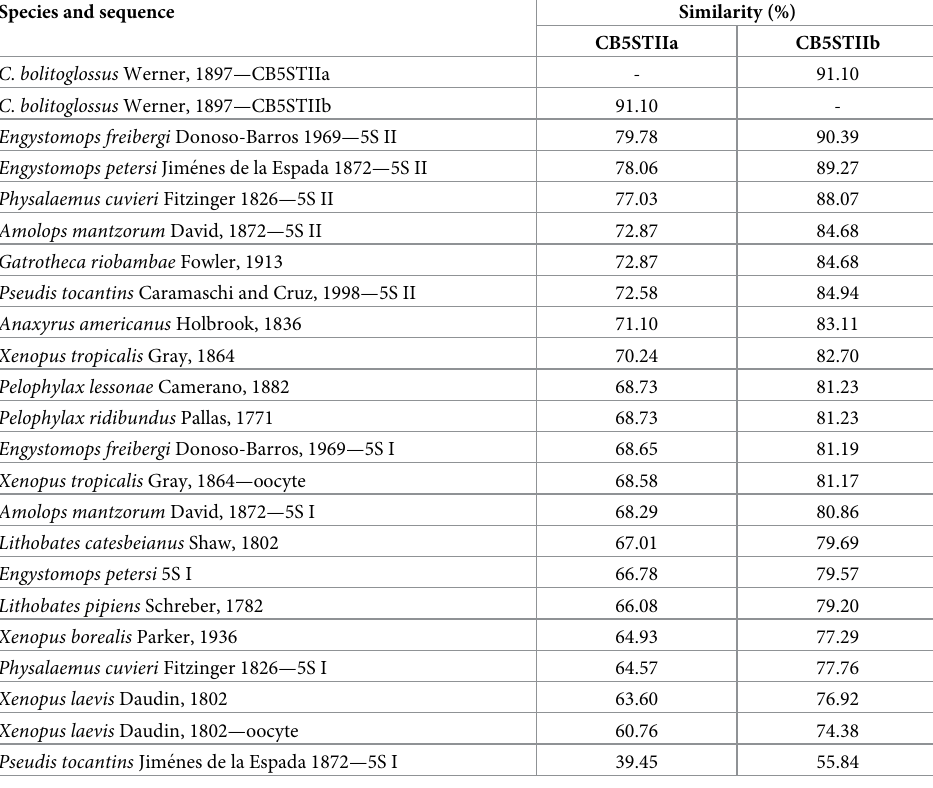
Table 1. rDNA 5S genetic similarity. Species and sequence Similarity (%)